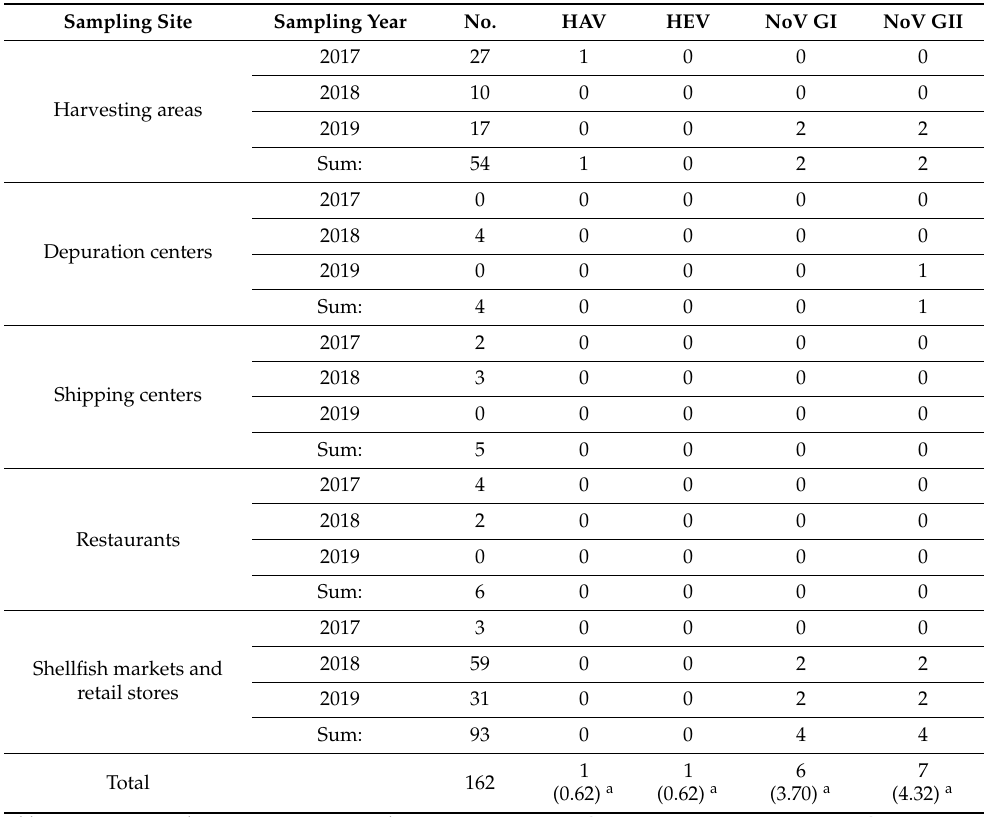
Table 2. Overview of molluscan shellfish sampled and contamination levels of enteric virus along the Sicilian shellfish chain.